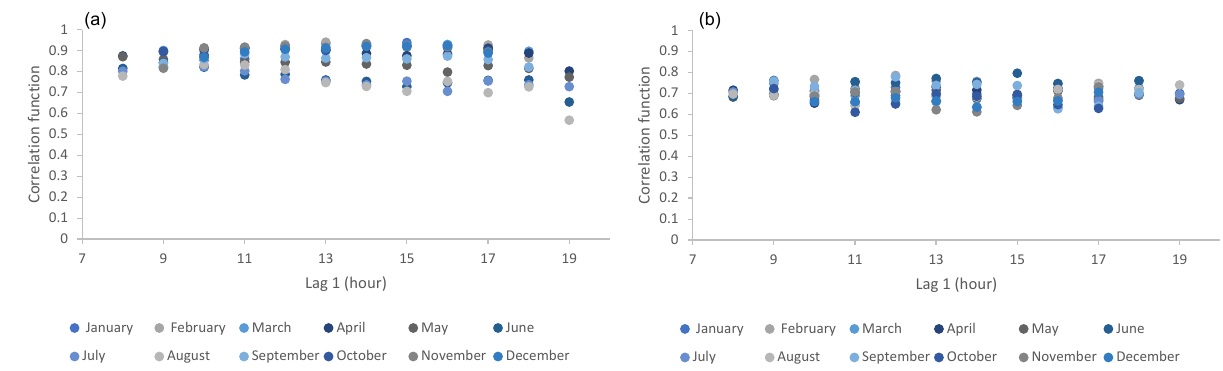
Figure 6. Lag-1 autocorrelation of hourly time series for each month (a) empirical; (b) simulated.